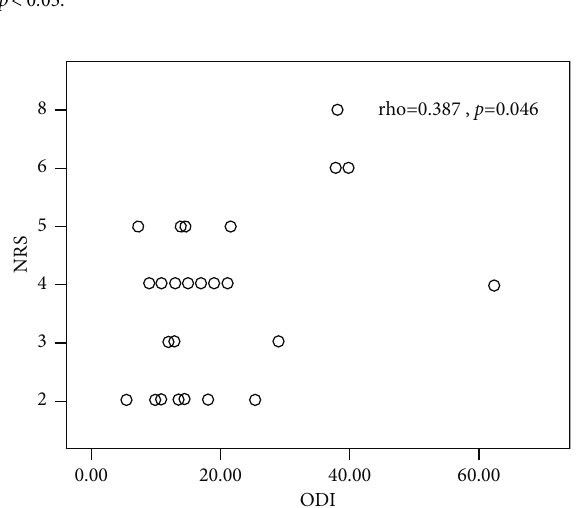
Figure 6: The association between ODI and NPR in cNLBP